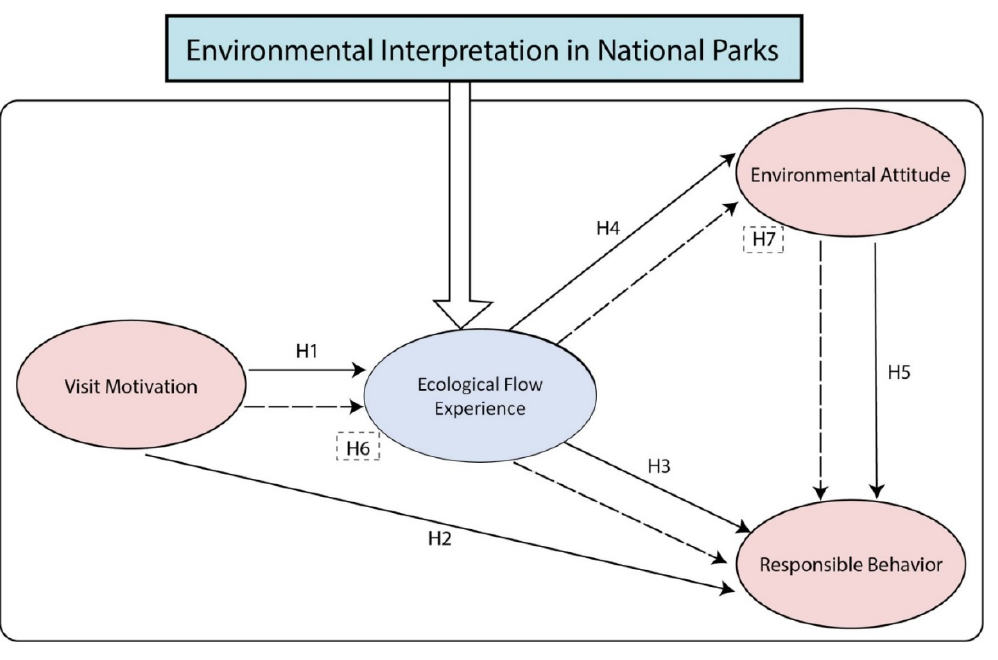
Figure 2. Conceptual